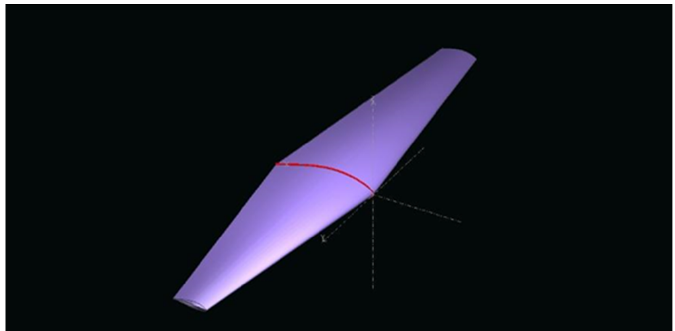
Figure 19. Model of the wing.